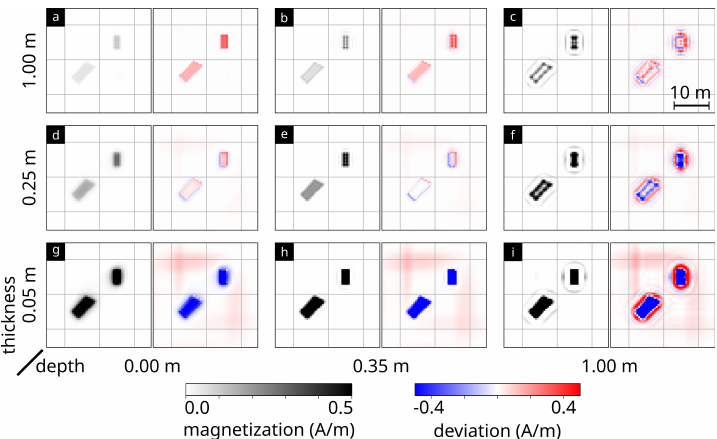
Figure 8. Magnetization distribution (each left one) derived by inverse filtering and its deviation to the reference model (each right one) for nine different filters with different depth d and thickness t combinations: ( a ) d : 0.00 m, t : 1.00 m; ( b ) d : 0.35 m, t : 1.00 m; ( c ) d : 1.00 m, t : 1.00 m; ( d ) d : 0.00 m, t : 0.25 m; ( e ) d : 0.35 m, t : 0.25 m; ( f ) d : 1.00 m, t : 0.25 m; ( g ) d : 0.00 m, t : 0.05 m; ( h ) d : 0.35 m, t : 0.05 m; ( l ) d : 1.00 m, t : 0.05